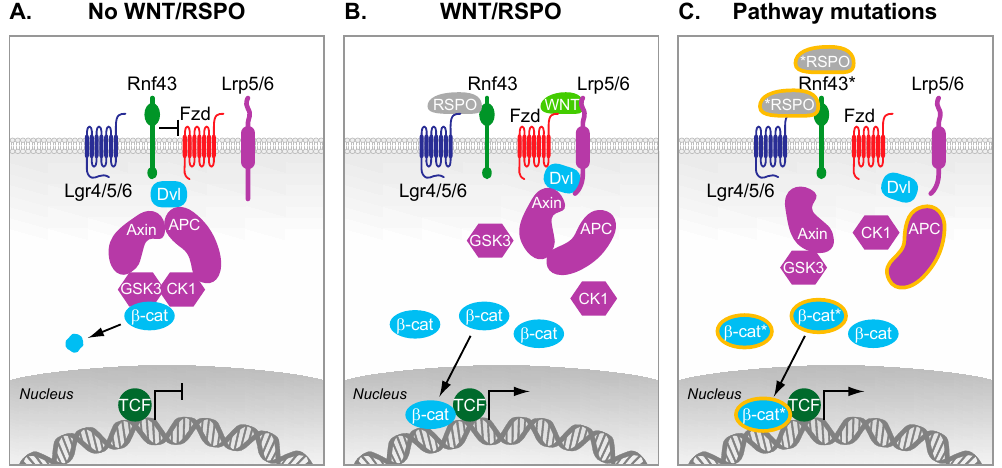
Figure 1. The Wnt signaling pathway. ( A ) In the absence of Wnt ligands and R-spondins, β -catenin is kept under low cytosolic levels by the destruction complex. This complex contains Axin2, Adenomatousis Polyposis Coli (APC), and the kinases Casein kinase 1 (CK1) and GSK3- β , which altogether primes β -catenin for proteasomal degradation; ( B ) R-spondins bind to Lgrs and RNF43, which results in the stabilization of Fzd receptors. Wnt ligands bound to Fzd and LRP5/6 co-receptors trigger formation of Dvl-Fzd complex and subsequent destabilization of the destruction